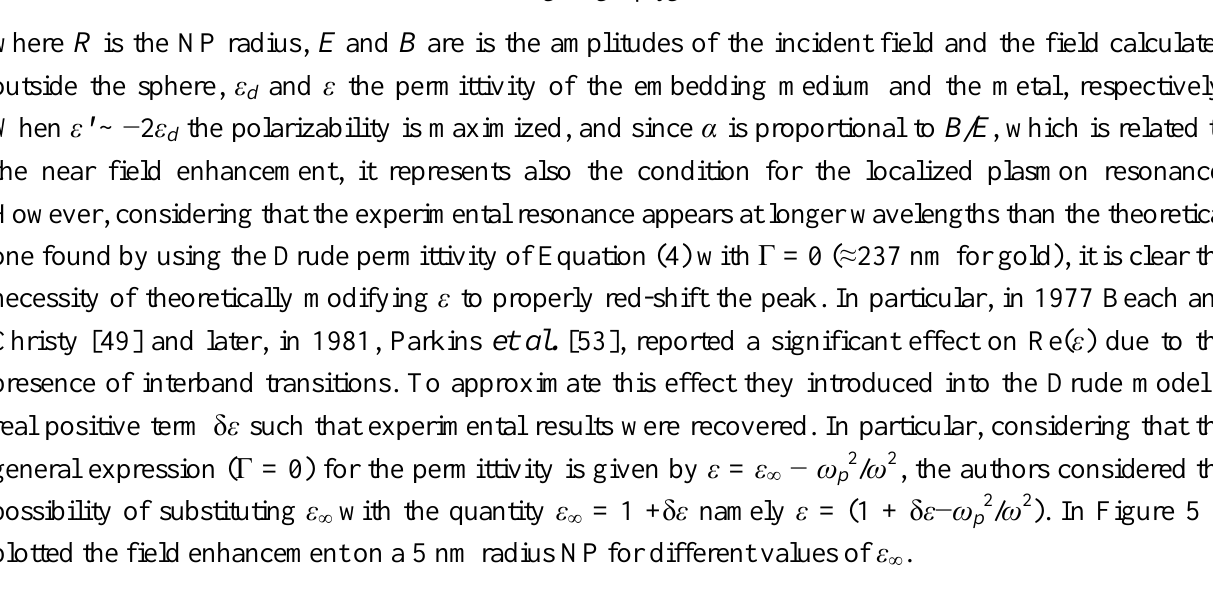
Figure 5. Electric field enhancement calculated at 1 nm from a gold nanoparticle. The particle radius is 5 nm and it is surrounded by air. Different values of ε been